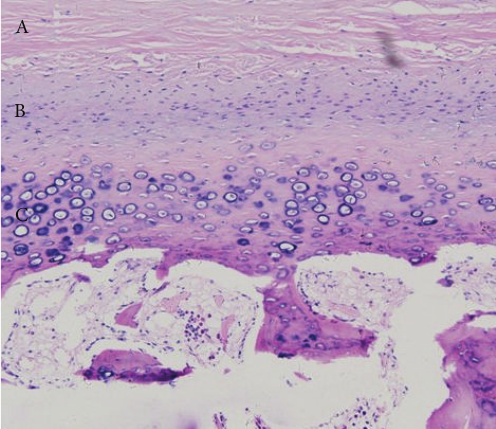
Figure 3: The pathology image of a patient (male, 21-year old) with UCH (HE × 100). (A) Obvious thickened perichondrium; (B) wide proliferative zone, small and flat-shaped undifferentiated mesenchymal cells distributed sparsely; (C) thickened hypertrophic layer (calcified cartilage